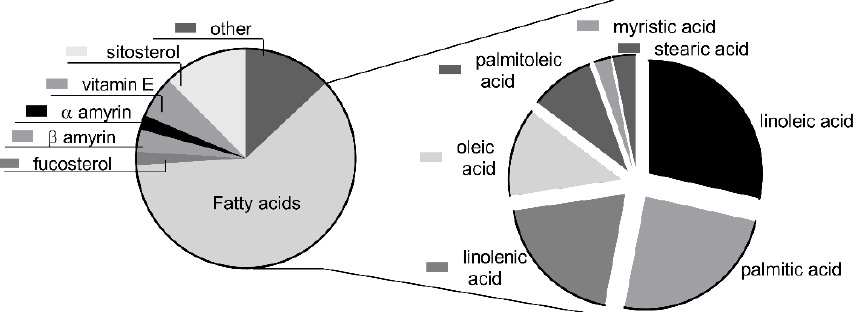
Figure 1. The chemical composition of the volatile fraction of sea-buckthorn seed oil, as assessed by gas chromatography – mass